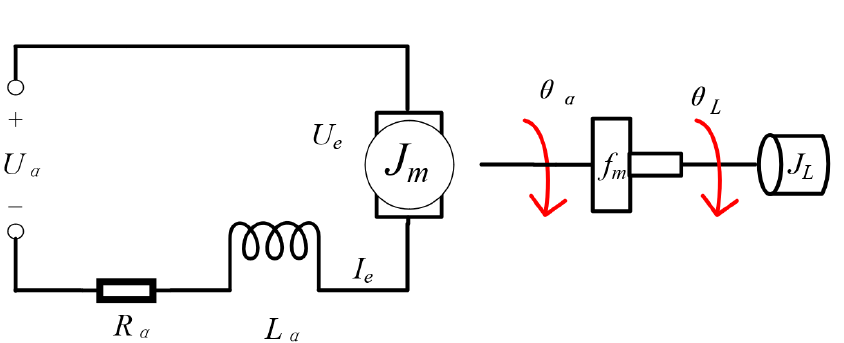
Figure 2. Physical model structure of the controlled